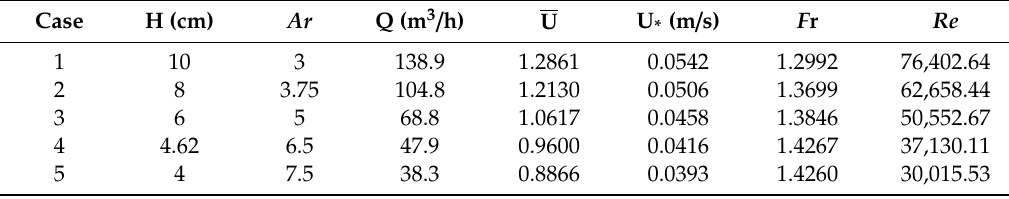
Table 1. Hydraulic parameters for experiments.